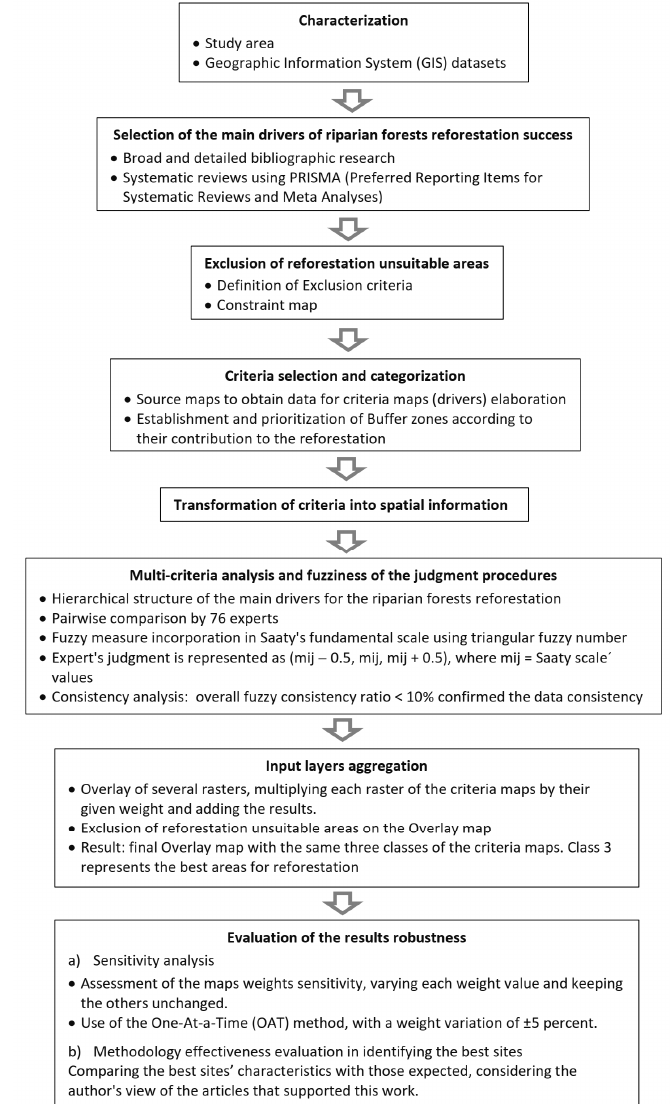
Figure 1. Synthesis of the methodology.